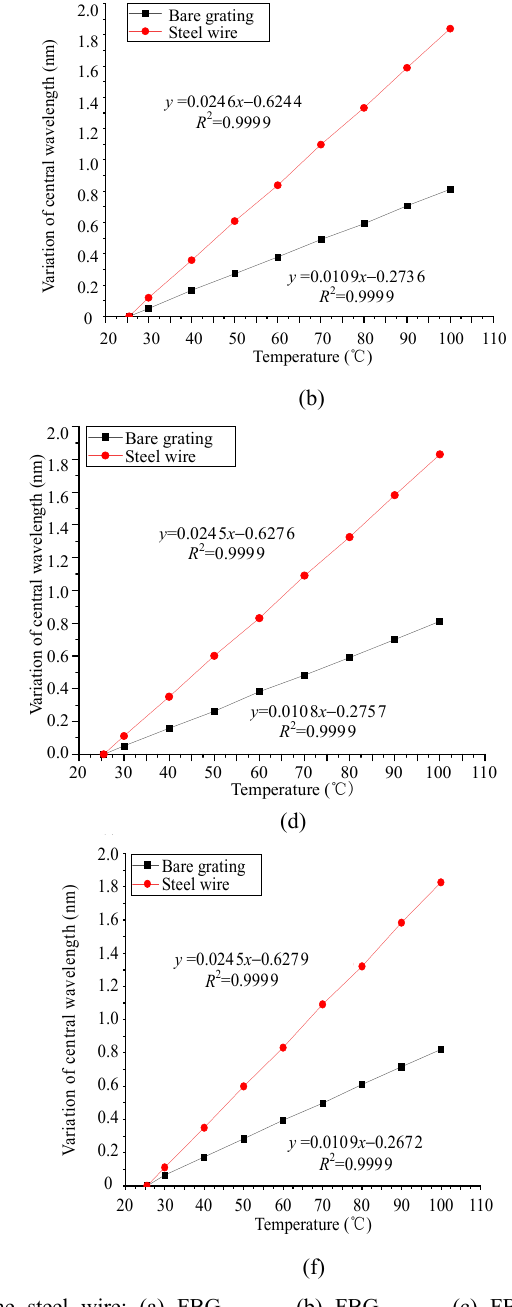
Fig. 3 and of the FBG sensor embedded in the steel wire: (a) FBG GS-A1-C , (b) FBG GS-A1-S , (c) FBG GS-A2-C , K K -F - T T M (d) FBG GS-A2-S , (e) FBG GS-A3-C , and (f) FBG GS-A3-S